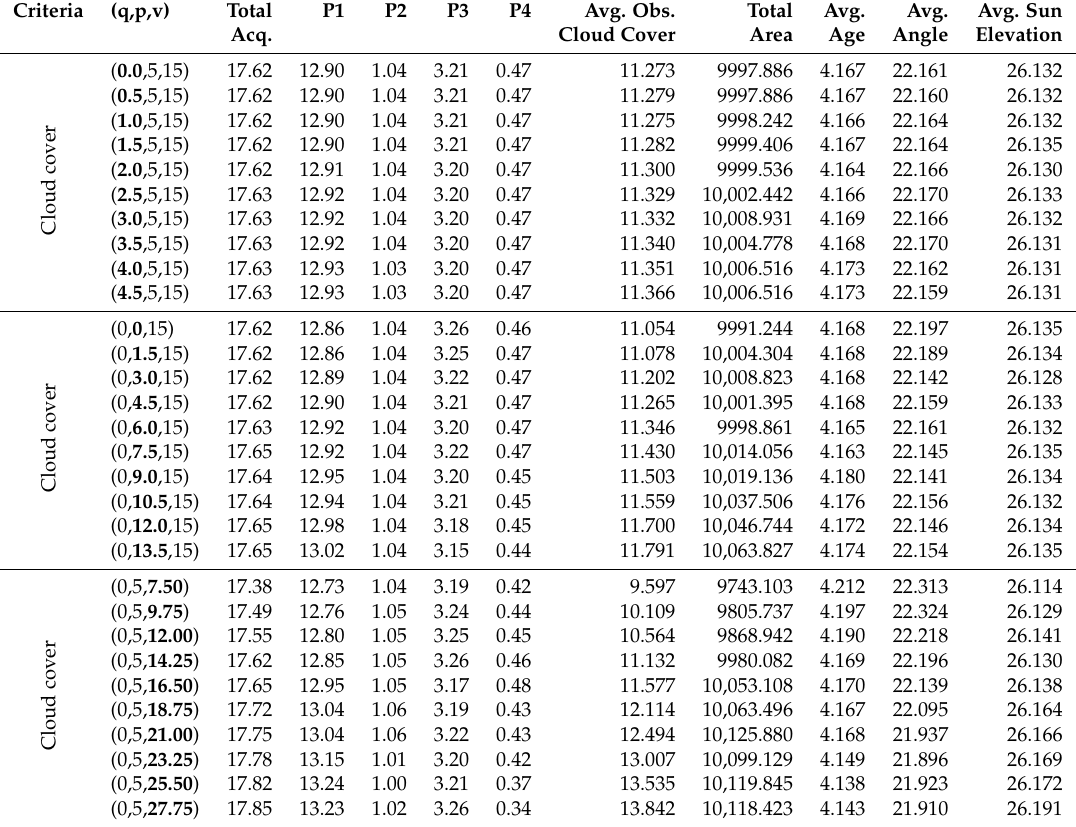
Table 7. This is the average performance measures for 100 generated scenarios, where the scoring through ELECTRE-III has been conducted with different threshold settings. Note, all other parameters are fixed, i.e., equal weights and initial threshold settings, and the results illustrate performance change of modifying a single threshold value for a specific criterion. To highlight the modified threshold values, we use